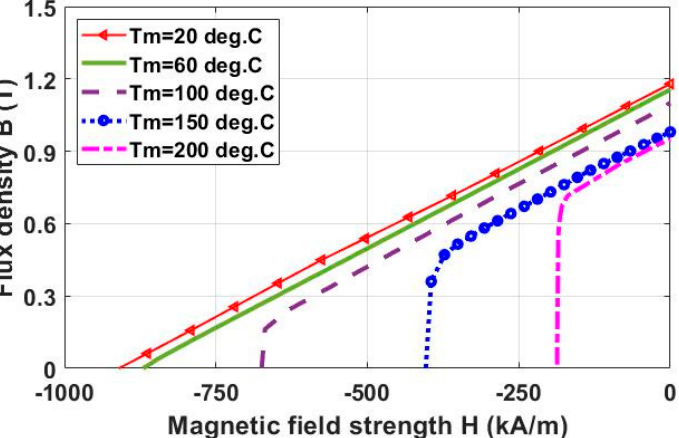
Figure 6. Temperature-dependent B(H) curves for PM material used in this paper.